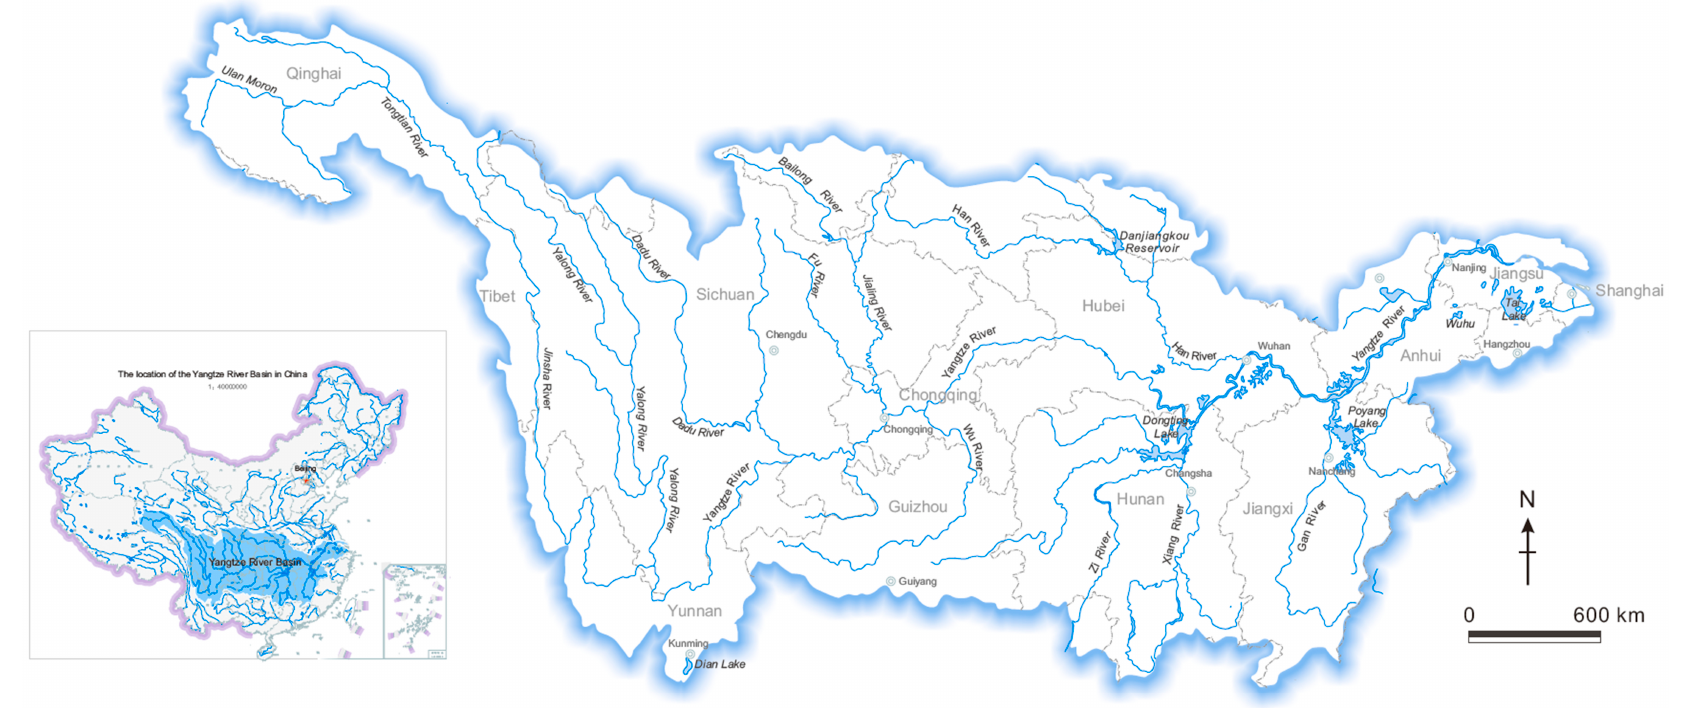
Figure 1. Location and the main topographic features of the Yangtze River.